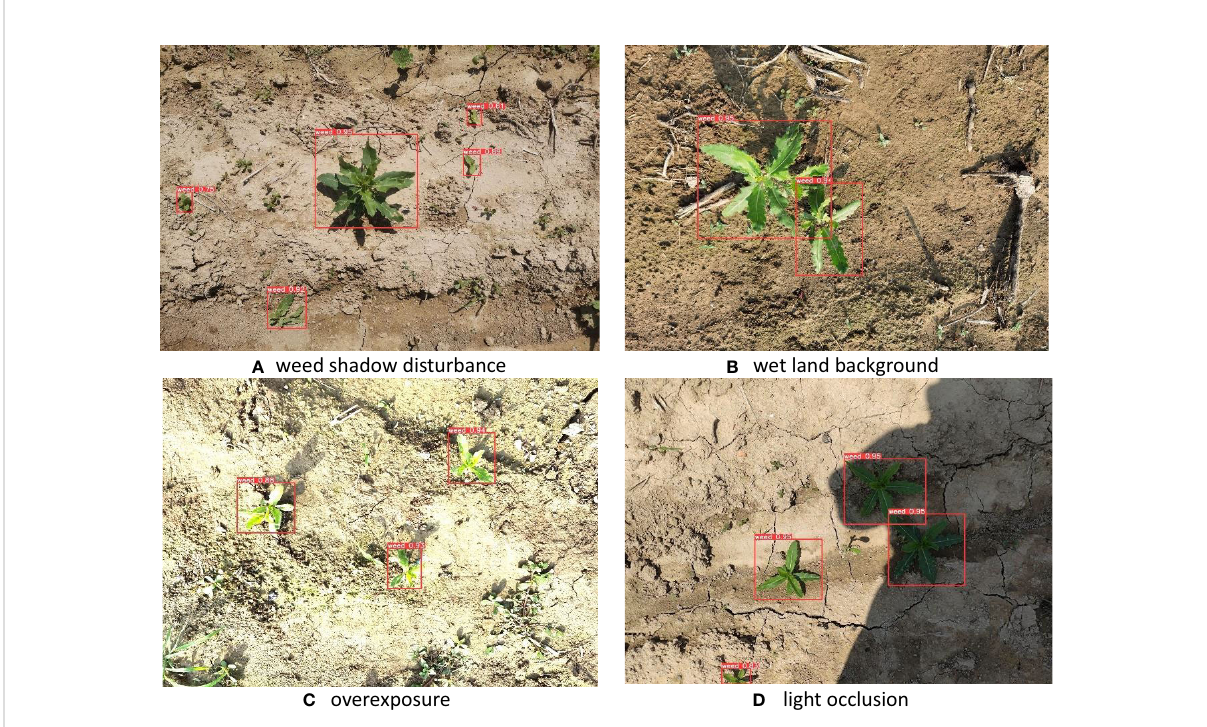
FIGURE 11 Prediction results for complex scenarios: The scenes from A to D are weed shadow disturbance, wet land background, overexposure, and light